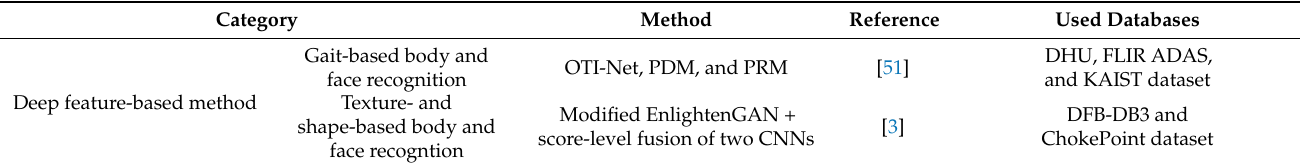
Table 5. Studies on face and body recognition robust to low illumination. All the methods used open